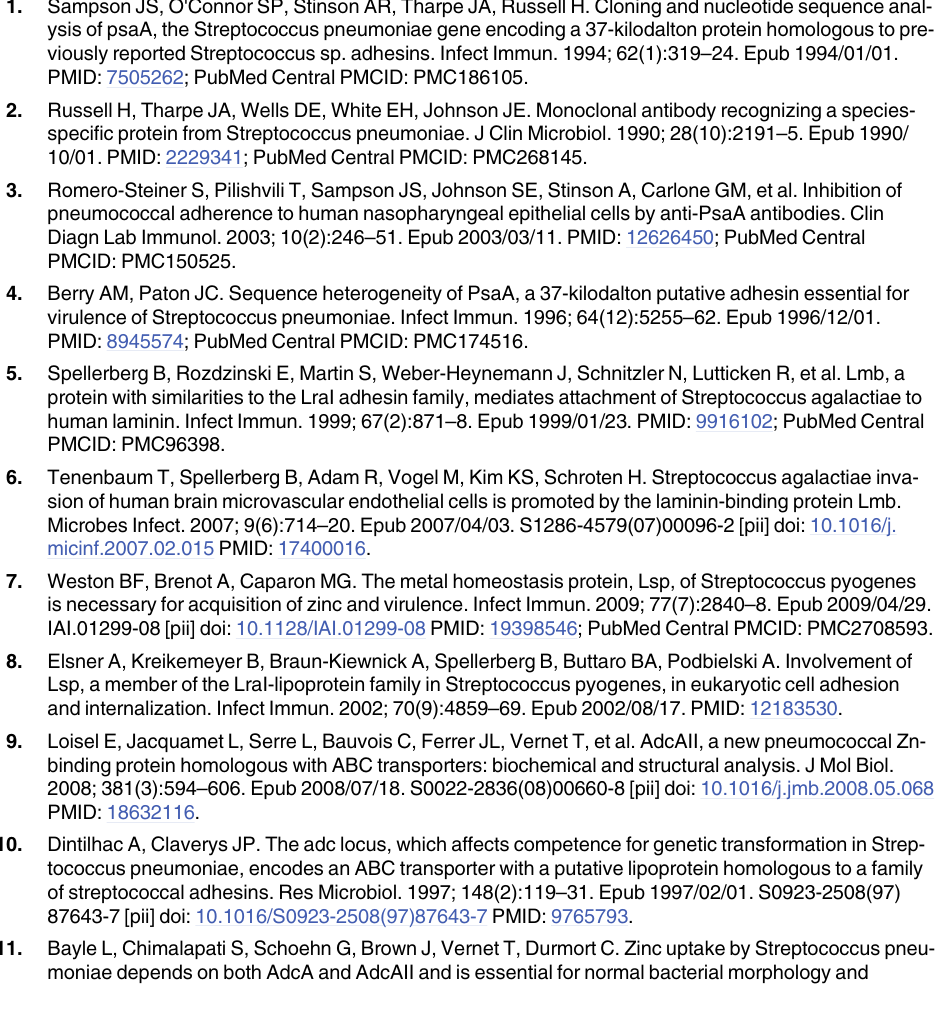
S1 Table. Mutagenesis Primers. S2 Table. Microarray Analysis of TIGR4 & Δ AdcAII. Bacterial RNA was harvested at OD 0.5 and used to synthesize cDNA for hybridization to pneumococcal